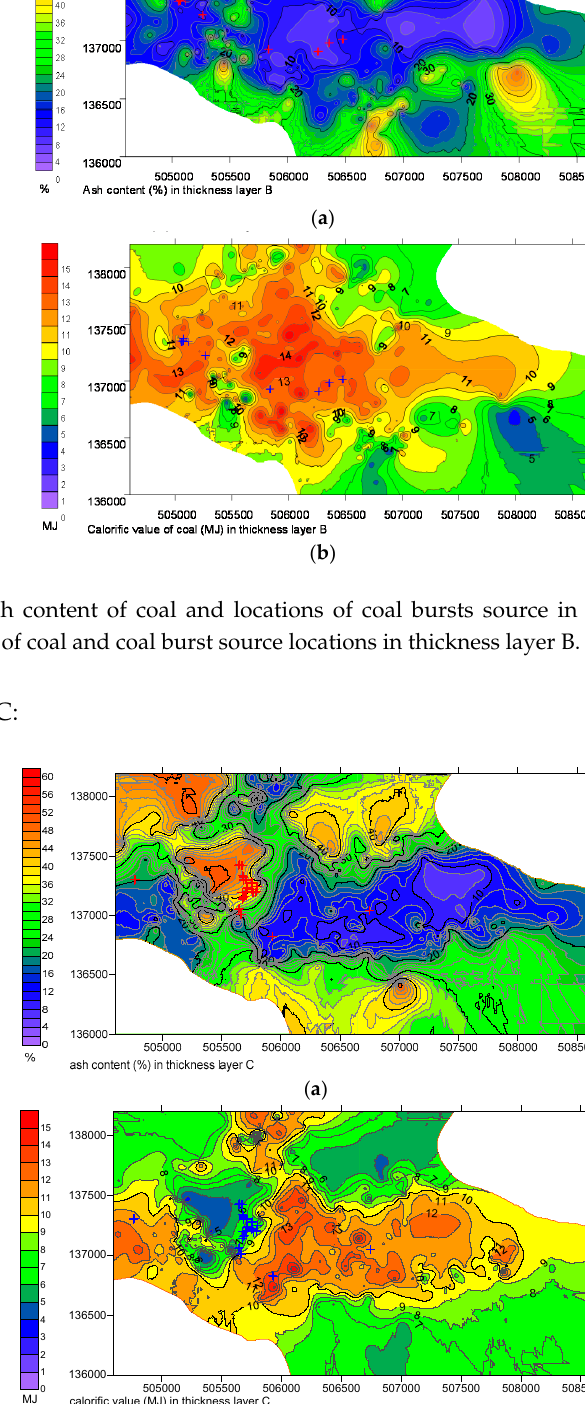
Figure 11. ( a ) Ash content of coal and locations of coal bursts source in thickness layer C; and ( b ) calorific value of coal and locations of coal bursts sources in thickness layer C.